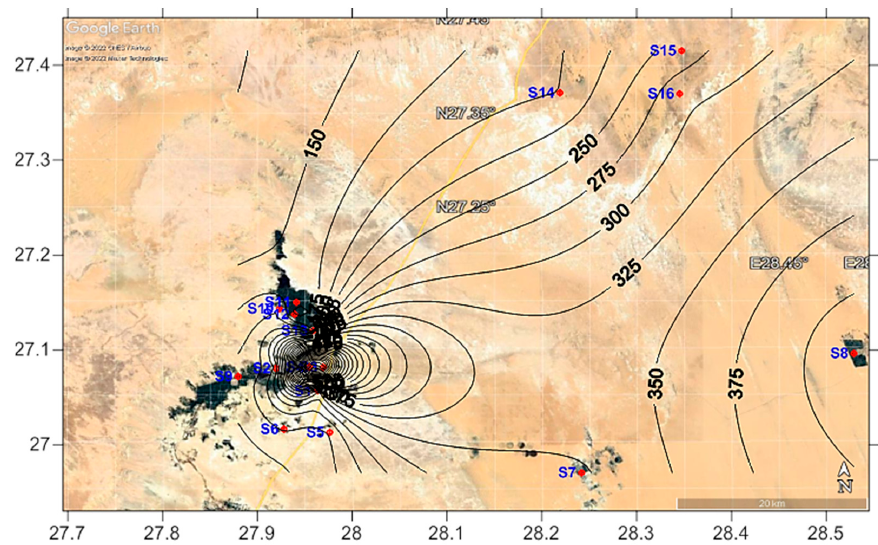
Figure 8. Spatial distribution of the total dissolved salts (TDS) in the study area.